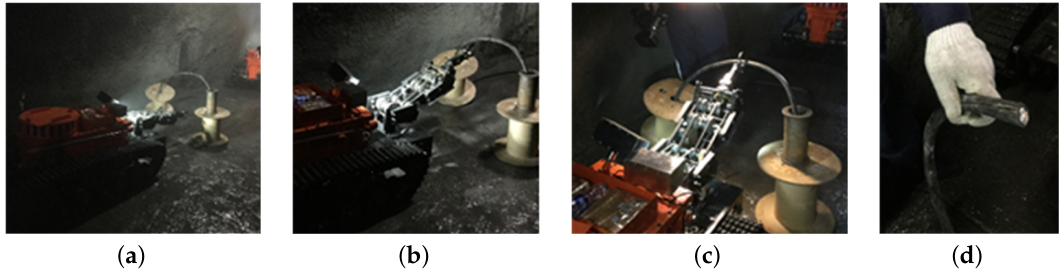
Figure 30. ( a – d ) show the manipulator prototype assembled on a mobile chassis and cutting out a cable controlled remotely [9]. ( a ) shows the manipulator preparing to aim at the cable. ( b ) shows the scissors aimed at the cable. ( c ) shows the scissors cutting the cable. ( d ) shows the cable being cut by the